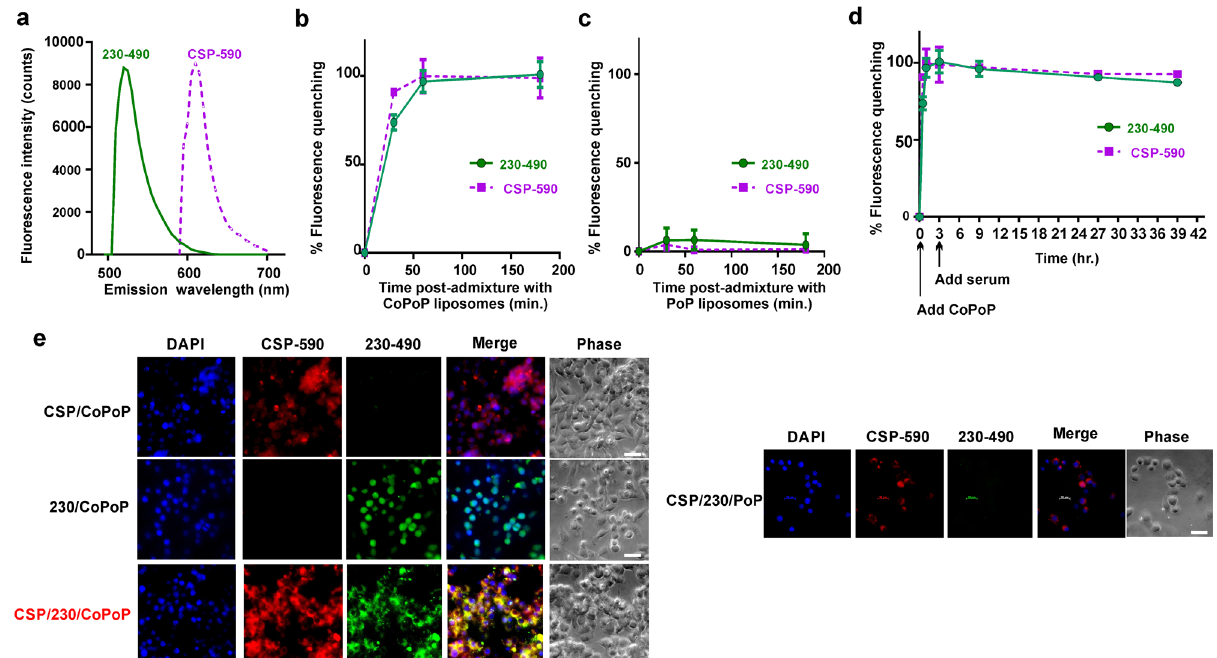
Fig. 3 Fluorescently-labeled CSP and Pfs230D1 + reveal particle formation, stability and macrophage uptake. a Fluorescence emission spectra of fl uorophore-labeled CSP ( “ CSP-590 ” ) and Pfs230D1 + ( “ 230-490 ” ). Binding kinetics of the bivalent antigens, measured in a single assay in real-time, as re fl ected by fl uorescence quenching upon admixture with ( b ) CoPoP liposomes or ( c ) PoP liposomes, which lack cobalt in the bilayer. d Serum stability of liposome-displayed bivalent antigens. Labeled antigens were fi rst incubated with CoPoP liposomes for 3 h, then human serum was added where indicated to a fi nal concentration of 20 % (v/v). e RAW264.7 cell uptake of bivalent antigens admixed with CoPoP liposomes and PoP liposomes for 4 h. Bar: 2 µ m. Graph points show mean ± s.d. for n = 3